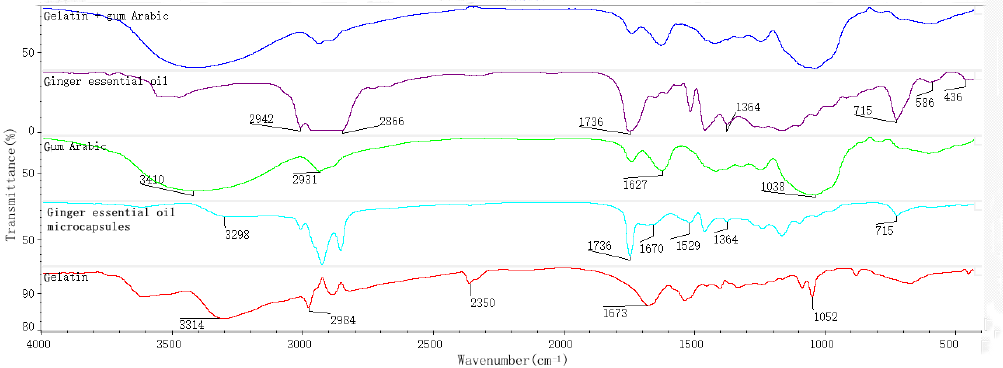
Figure 1. FTIR spectra of gelatin, gum Arabic, gelatin and gum Arabic, ginger essential oil, and giner essential oil micro- capsules.